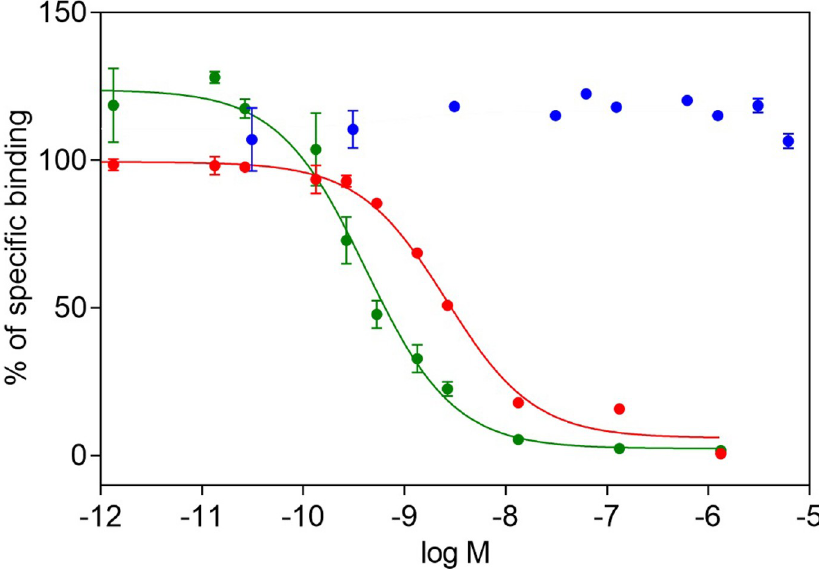
Fig 3. Representative binding curves of IGF hormones on immobilized D11. Inhibition of binding of human [ 125 I]- monoiodotyrosyl-Tyr2-IGF2 to D11 by human IGF2 (in red), by human IGF1 (in blue), and by Leu19-IGF2 analog (in